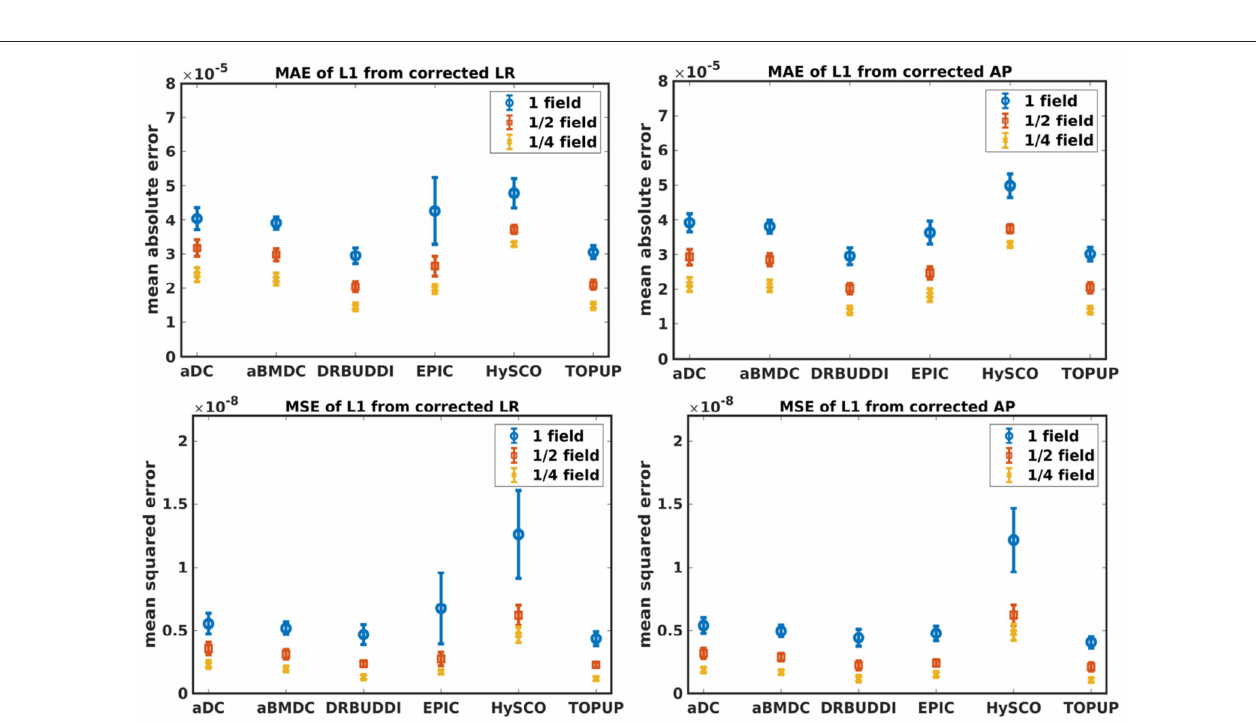
FIGURE 8 | MAE (Top) and MSE (Bottom) of principal eigenvalues for five simulated HCP subjects using the six methods. The error bars represent standard deviation over subjects. Correction was carried out for LRRL (Left) and APPA (Right) pairs, respectively. Three levels of susceptibility distortion were simulated.